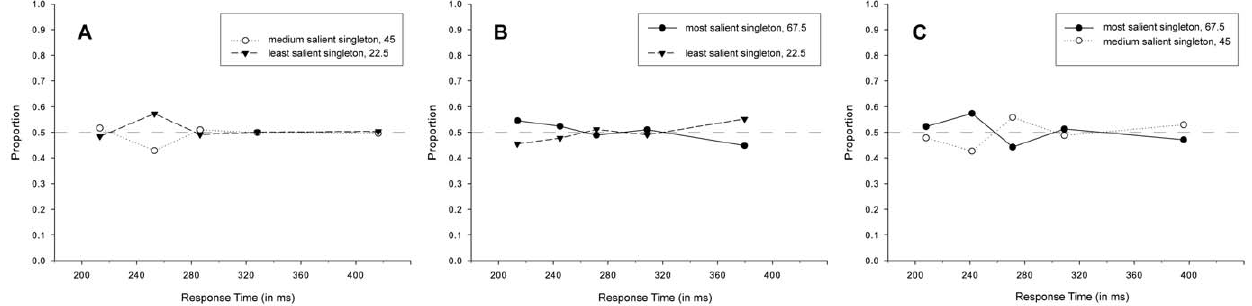
Figure 3. Salience-driven selection in second saccades in Experiment 1. Proportions of second saccades directed toward either of the two remaining singletons, separately for each bin of the response time distribution and irrespective of target identity, given that the initial saccade landed on A) the most, B) the medium, or C) the least salient singleton.